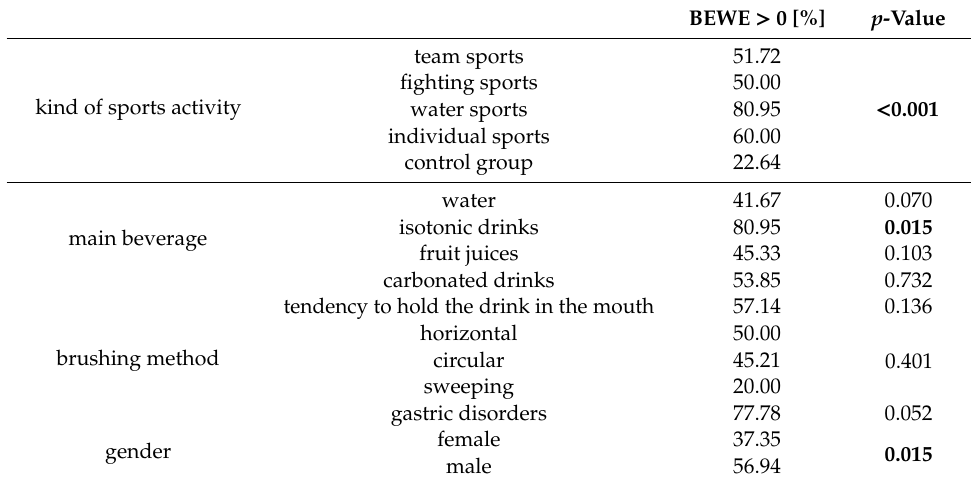
Table 2. Selected potential risk factors for erosive